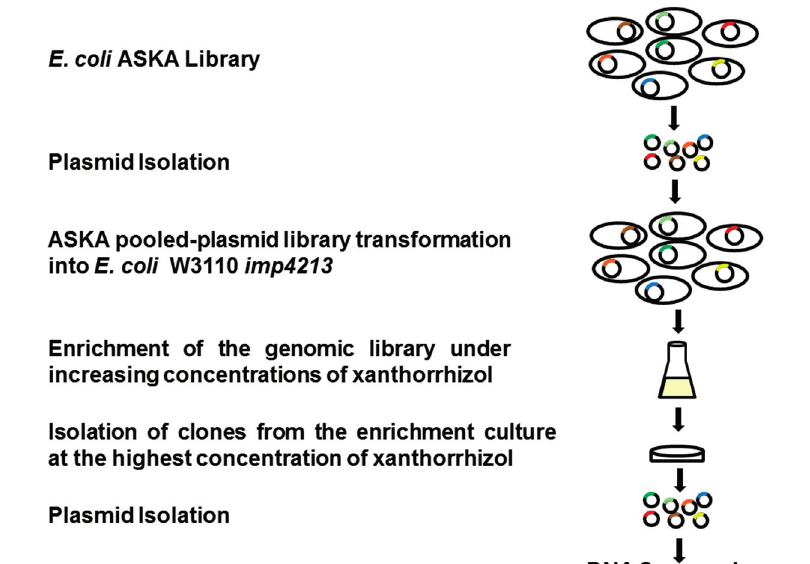
Figure 5. A scheme of the ASKA pooled-plasmid library enrichment screen for targets that confer xanthorrhizol resistance on E. coli W3110 imp4213 . The ASKA plasmid library was isolated and re-introduced into competent E. coli W3110 imp4213 cells by electroporation. The E. coli W3110 imp4213 ASKA plasmid library clones were pooled and cultivated in LB medium containing chloramphenicol (30 µg/mL) in the absence or presence of xanthorrhizol (8–512 µg/mL). Cells cultured from the highest xanthorrhizol concentration were spread onto LB agar medium containing chloramphenicol (30 µg/mL), tetracycline (10 µg/mL) and appropriate concentrations of xanthorrhizol. The resulting colonies were randomly chosen for plasmid isolation followed by DNA sequencing